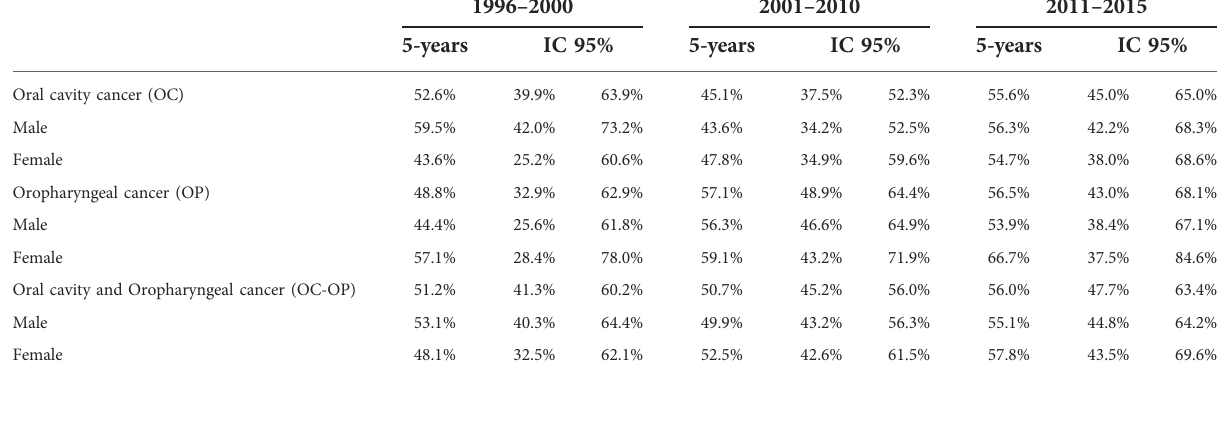
TABLE 3 Five-year survival by subtype, sex and period. Years 1996 –